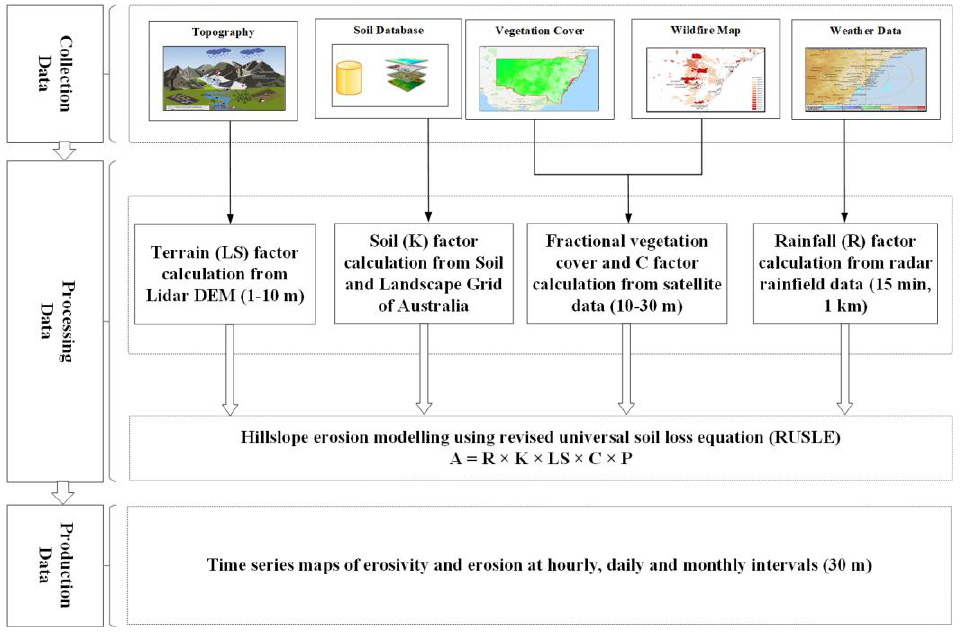
Figure 2. The general procedures of hillslope erosion modeling in this study.